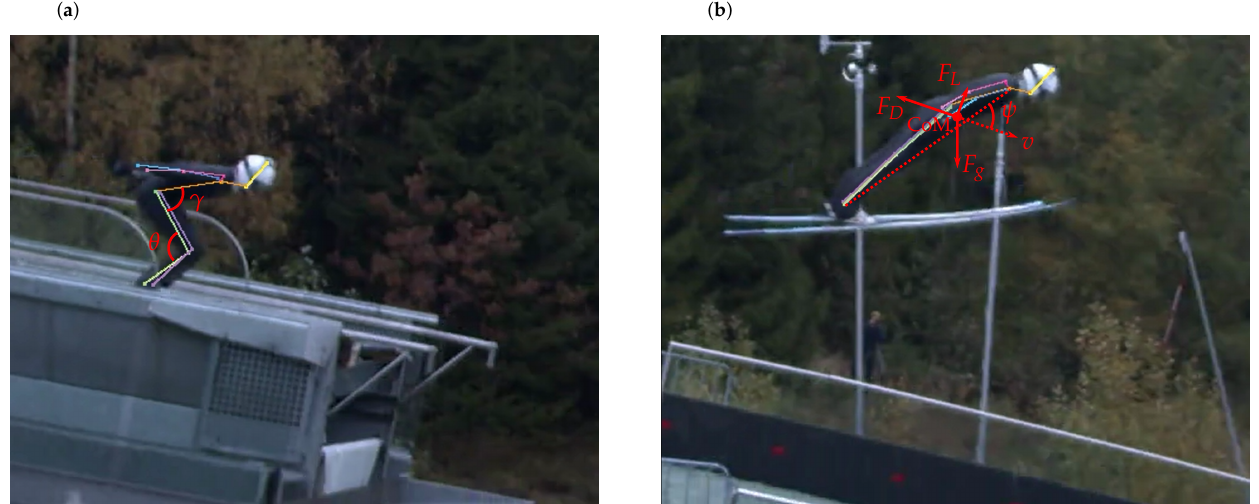
Figure 4. Definition of parameters calculated from the PosEst data: ( a ) shows the knee angle ( θ ) and the hip angle ( γ ). ( b ) the centre of mass (CoM), gravitational force ( F g ), drag force ( F D ), lift force ( F L ), body angle of attack ( ψ ) and the resultant speed of the ski jumper ( v